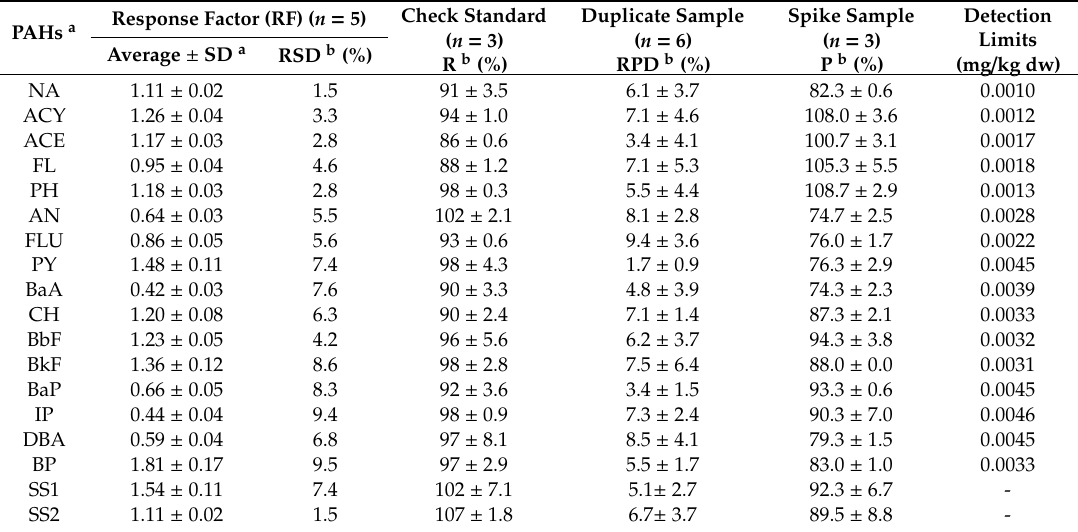
a The definitions of compound abbreviation see Table 2; b SD: standard deviation; RSD: Relative standard deviation; R: Recoveries of check standard; RPD: Relative percent di ff erences; P: Recoveries of spike